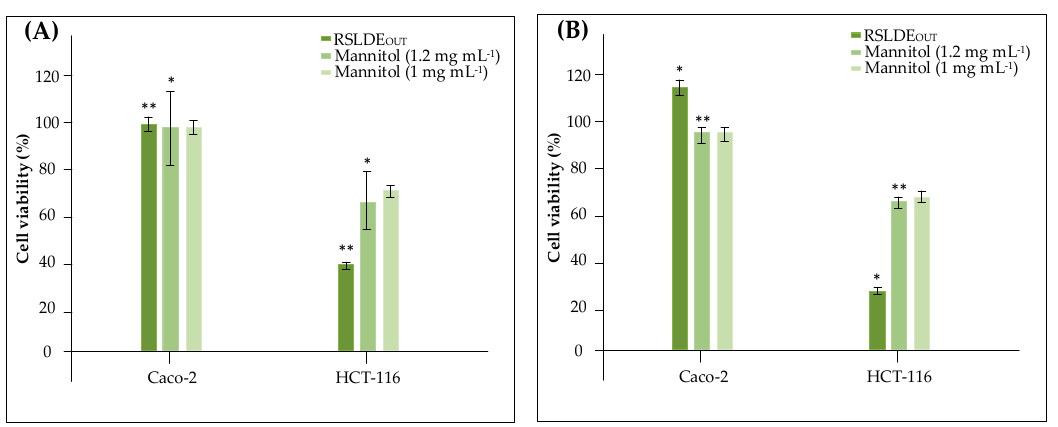
Figure 6. Caco ‐ 2 and HCT ‐ 116 cytotoxicity under different mannitol concentrations (0, 1.0, 1.2, 2.43, 4.5, 9.0 mg mL − 1 ). MTT (3 ‐ (4,5 ‐ dimethylthiazol ‐ 2 ‐ yl) ‐ 2,5 ‐ diphenyltetrazolium) cell viability after 24 ( A ) and 48 h ( B ) exposure.